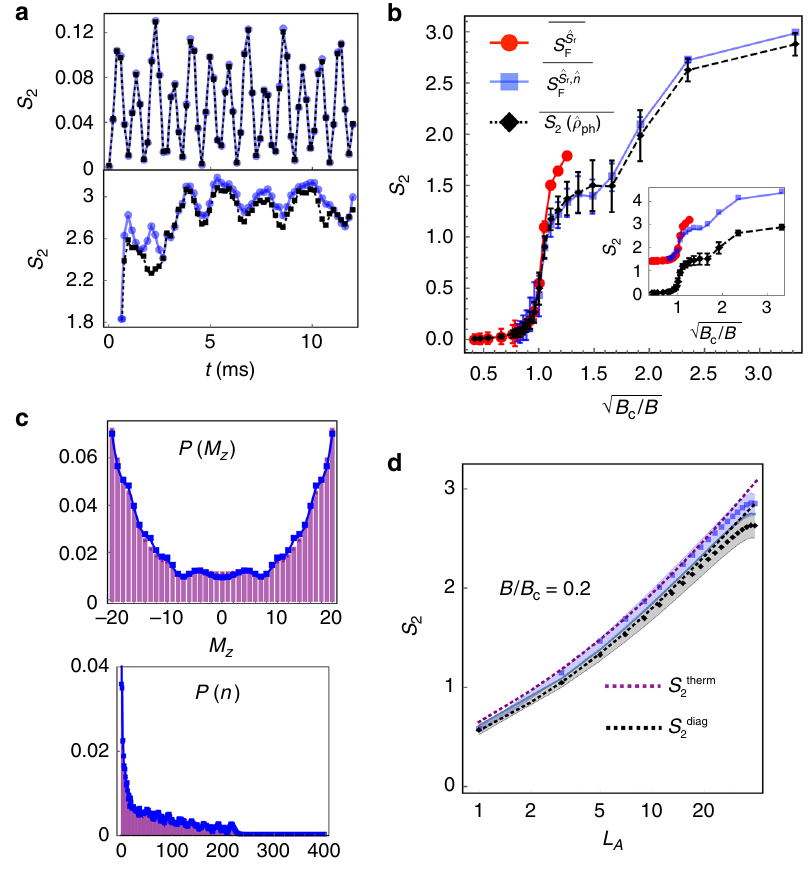
Þ (black lines) for ph i 0